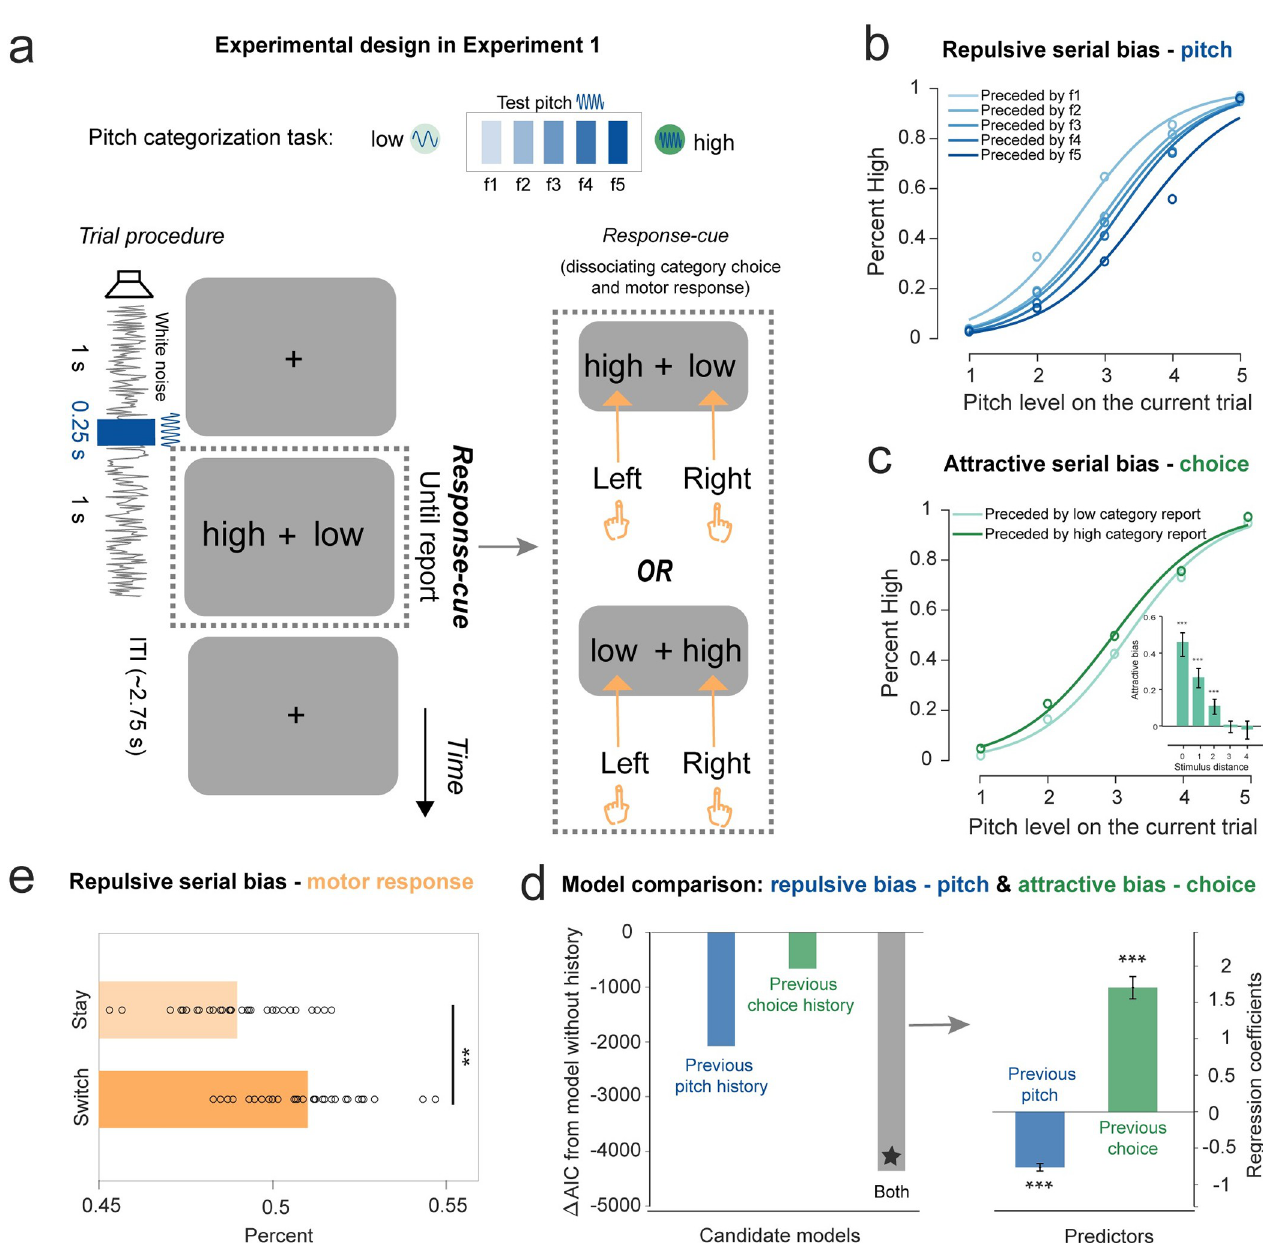
Fig 1. Task paradigm and behavioral serial bias in Experiment 1. ( A ) Auditory categorization task paradigm. Upper: Pitch of the pure tone stimulus was pseudorandomly selected from 5 fixed frequencies (f1, f2, f3, f4, and f5) between 180 Hz (low category; light green) and 360 Hz (high category; dark green). Lower: In each trial, participants categorized a given 0.25-s pure tone (dark blue; selected from f1, f2, f3, f4, and f5) embedded in a 2.5-s sustained white noise stream (grey line) into “high” (closer to 360 Hz) or “low” (closer to 180 Hz) category. After the pure tone, a response–cue screen appeared, based on which participants used the corresponding hand to made responses (right inset). ( B ) Pitch serial bias (aggregate results across participants). “High” category choice percent as a function of the current pitch, for different pitch in previous trial (Light-to-dark color lines denote low-to-high pitches). Each circle represents aggregated data for each condition. Solid lines represent the logistic regression fits. ( C ) Category serial bias (aggregate results across participants). “High” category choice percent as a function of the current pitch, for different category choice in the previous trial (light green: low category choice; dark green: high category choice). The subpanel shows how the category choice serial bias is modulated by the previous-current pitch distance. Error bars represent 95% confidence interval. ( D ) Model comparison results. Left: Δ AIC of Model 2 (blue; current trial + previous pitch), Model 3 (green; current trial + previous category choice), and Model 4 (grey; current trial + previous pitch + previous category choice), compared to Model 1 (current trial only). Right: Regression coefficients for previous pitch (blue) and previous category choice (green) extracted from the winning model (Model 4, * in model comparison). Error bars represent 95% confidence interval. ( E ) Motor response serial bias (left or right hand). “Switch” trials (dark orange): percentage of trials that are different from previous trial in motor response. “Stay” trials (light orange): percentage of trials that are the same as previous trial in motor response. Each circle represents